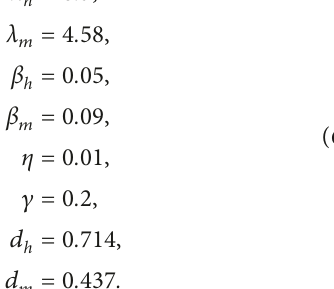
Table 3: ξ values and τ ∗ values for different fractional-order α 0 3